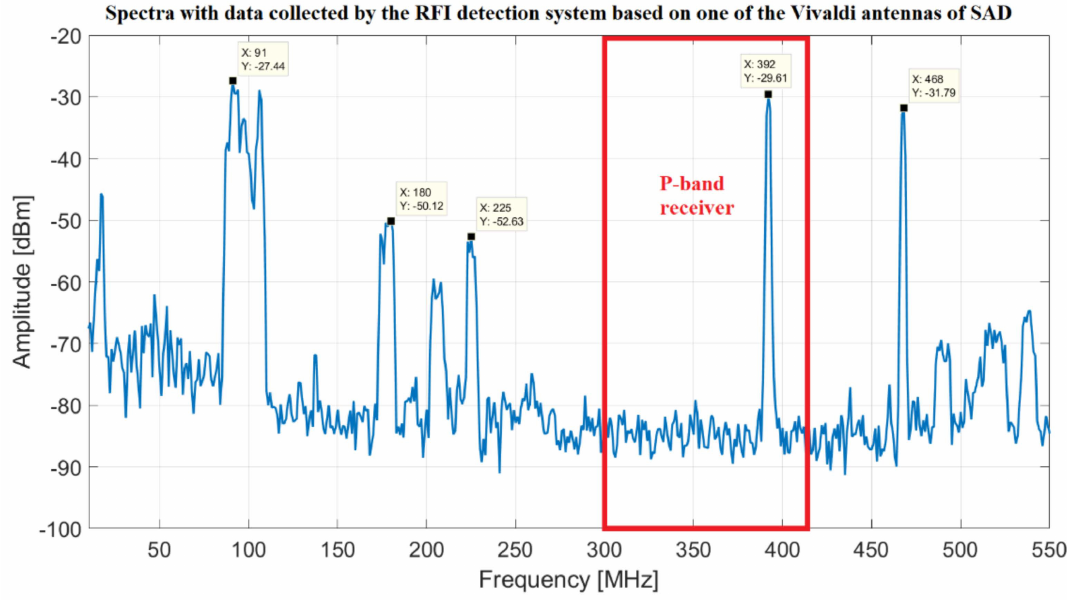
Figure 8. Spectra with data collected by the RFI detection system based on Sardinia Aperture Array Demonstrator